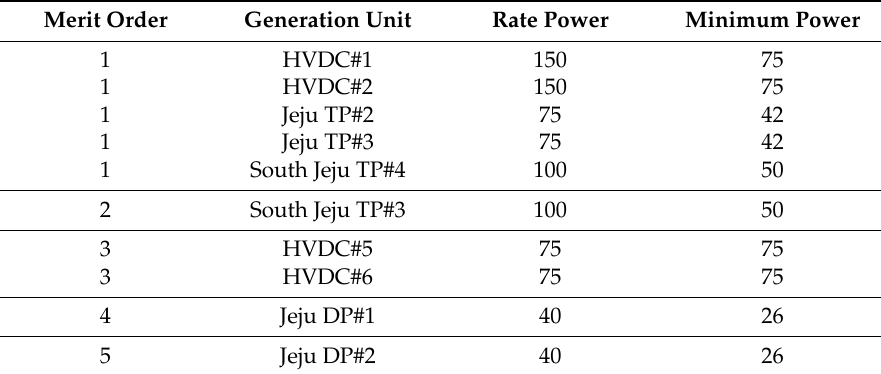
Table 2. Rate power and minimum power of generation